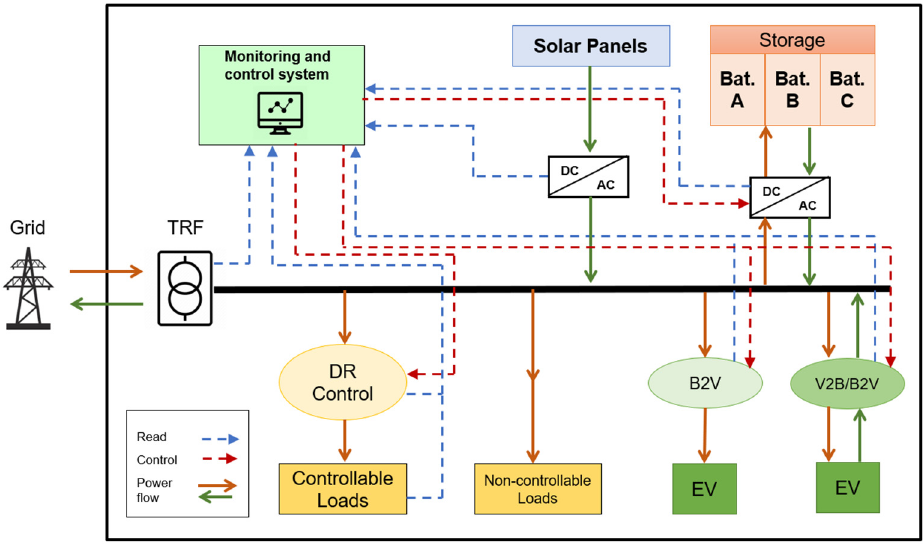
Figure 2. Schematic of the existing microgrid.